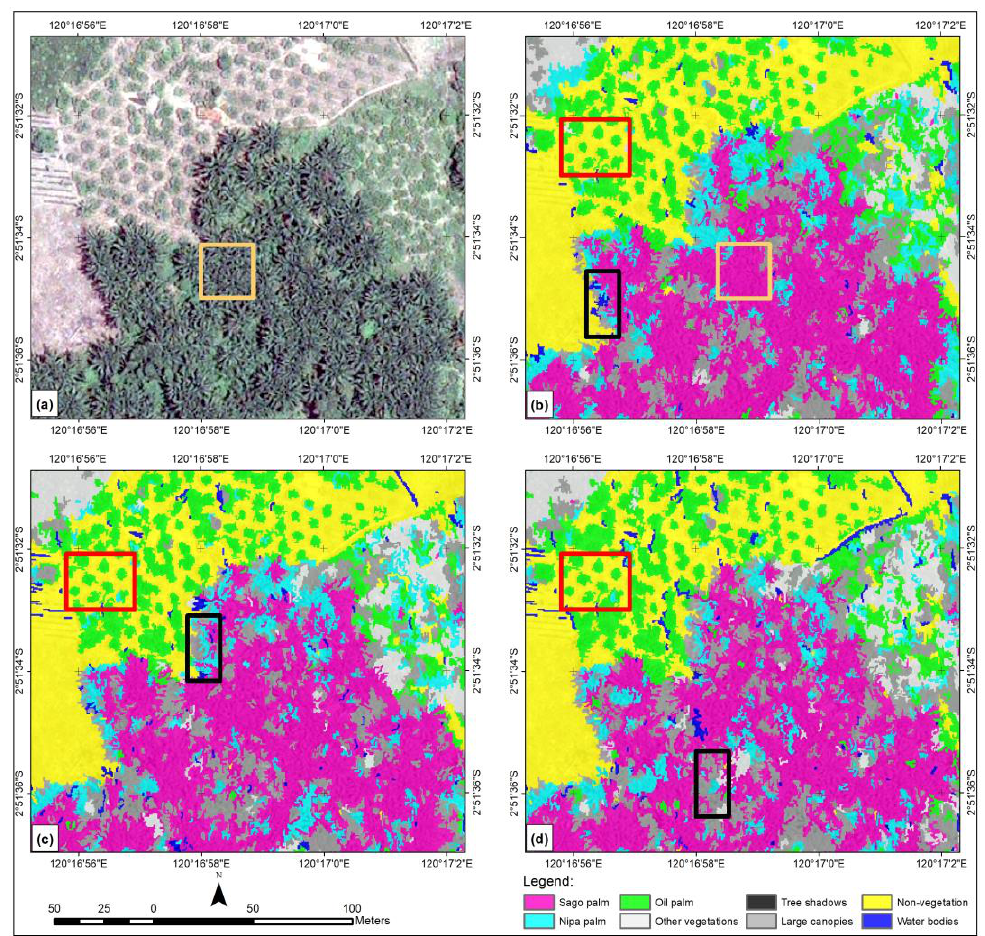
Figure 7. A series showing ( a ) a natural color composite of the whole Pleiades-1A test image with sago palm clumps dominating the subset; ( b ) an SVM classified image using eight features; ( c ) an SVM classified image using 20 features; and ( d ) an SVM classified image using 26 features.